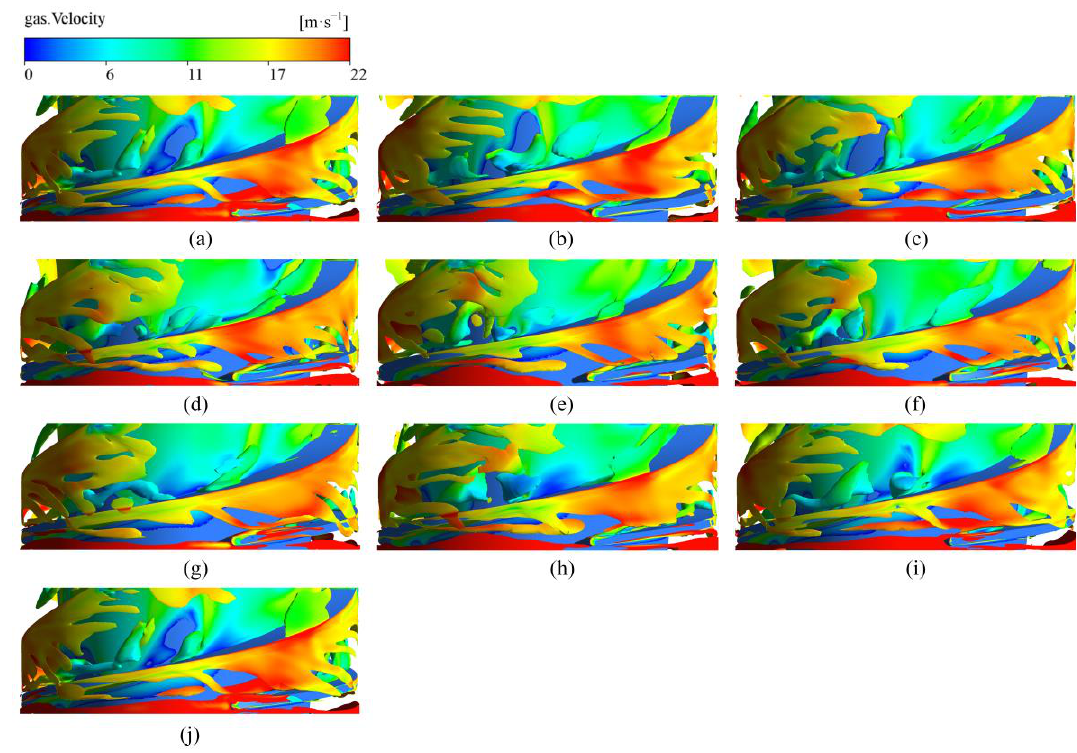
Figure 12. 3D evolution of the gas with IGVF of 10%. ( a )T 0 ; ( b ) T 0 + 1/9T; ( c ) T 0 + 2/9T; ( d ) T 0 + 3/9T; ( e ) T 0 + 4/9T; ( f ) T 0 + 5/9T; ( g ) T 0 + 6/9T; ( h ) T 0 + 7/9T; ( i ) T 0 + 8/9T; and ( j ) T 0 + T.